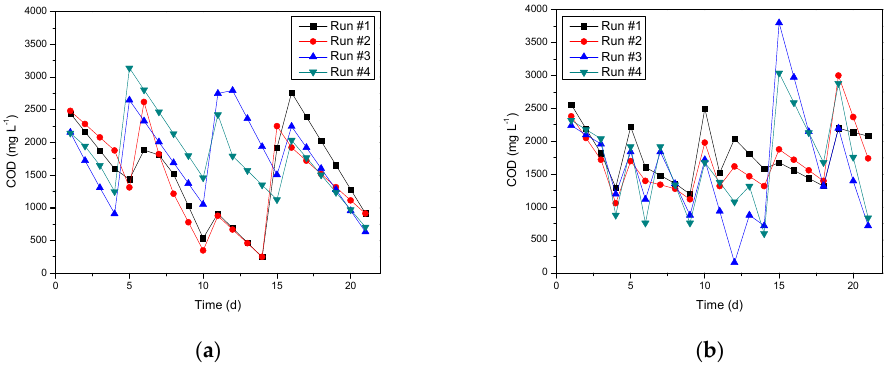
Figure 2. COD consumption and feeding profiles during chronoamperometry at ( a ) +0.34 V/SHE and ( b ) − 0.16 V/SHE polarization potential.